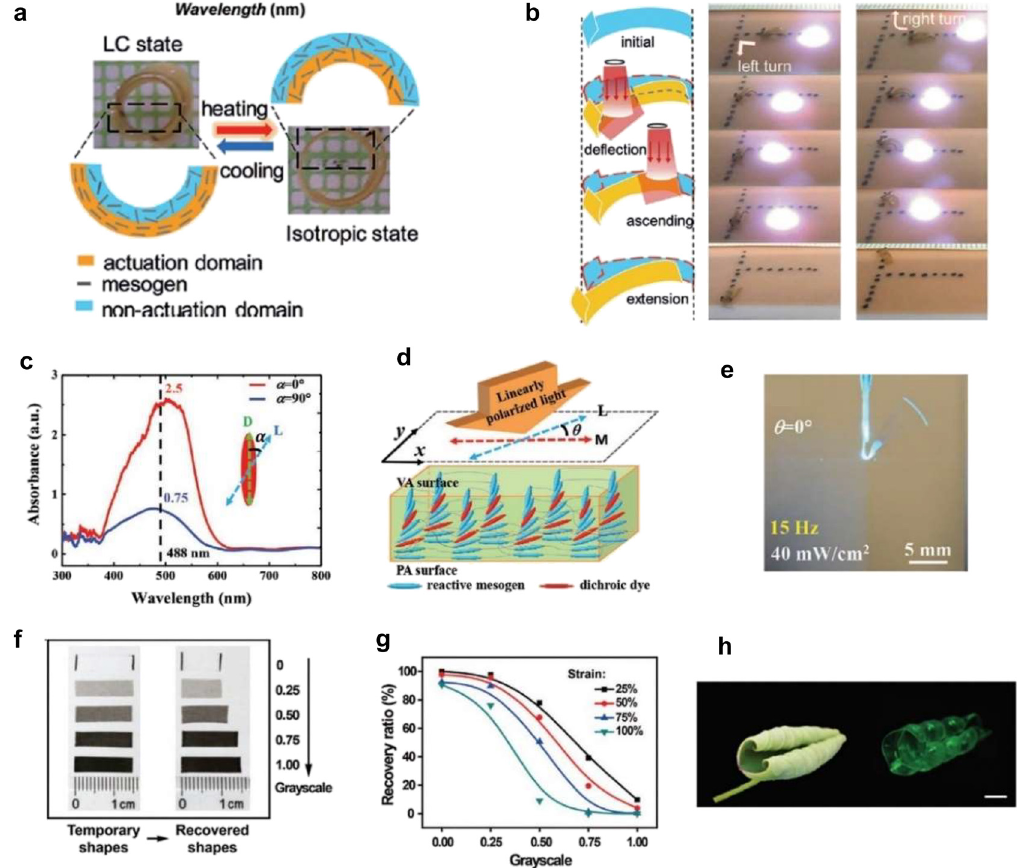
Figure 6: General photothermal method for light activation: dye molecules and colored